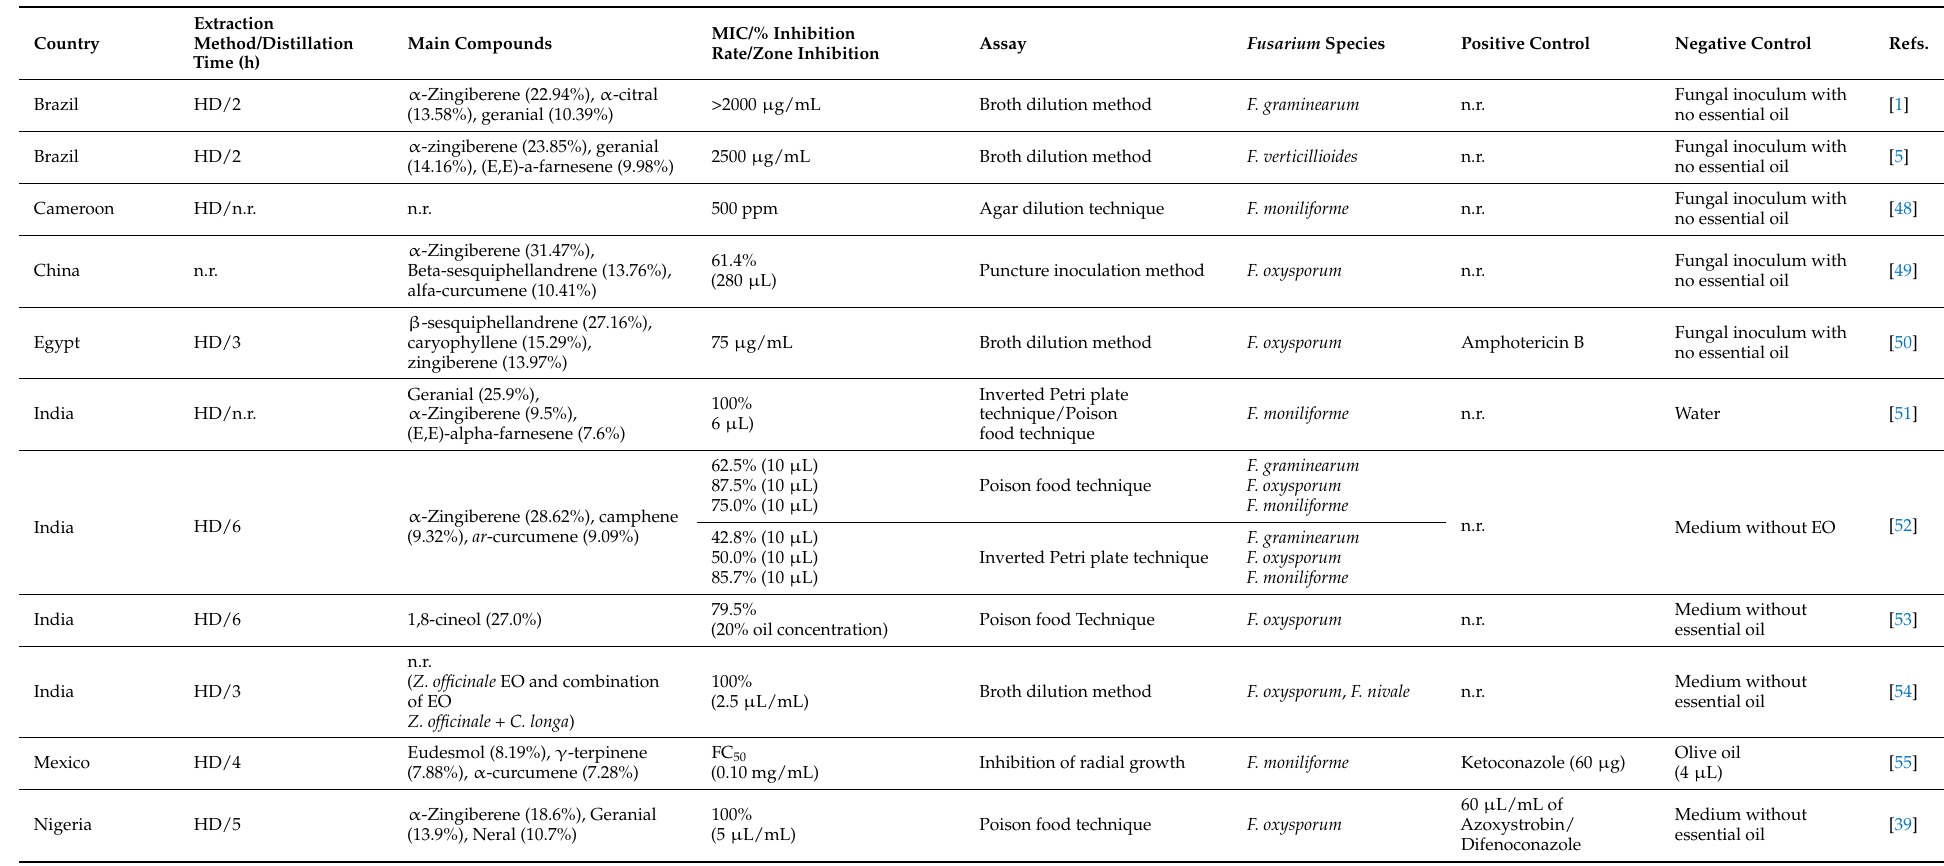
Table 1. Antifungal activity of Z. officinale essential oil against Fusarium